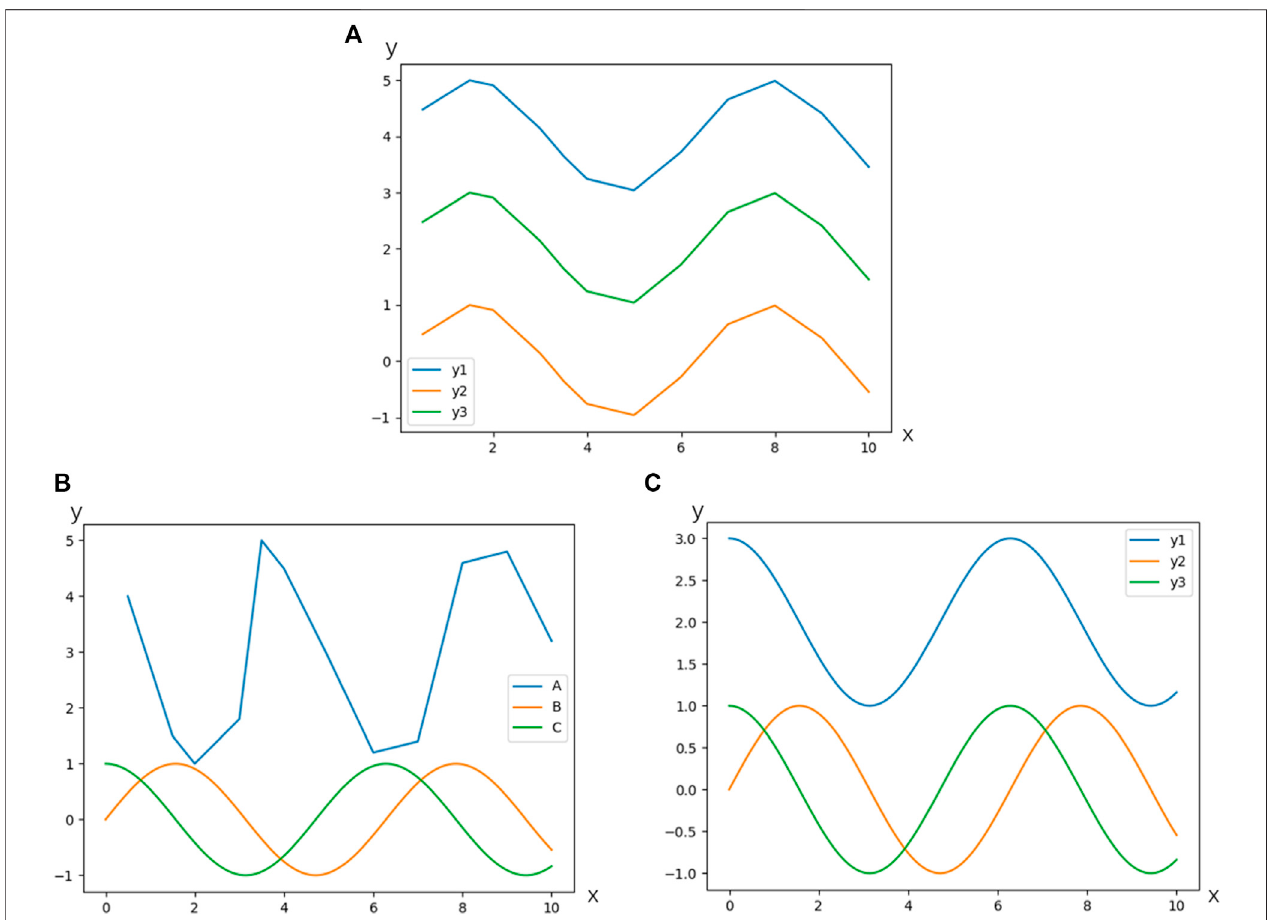
FIGURE 3 | De fi nition of